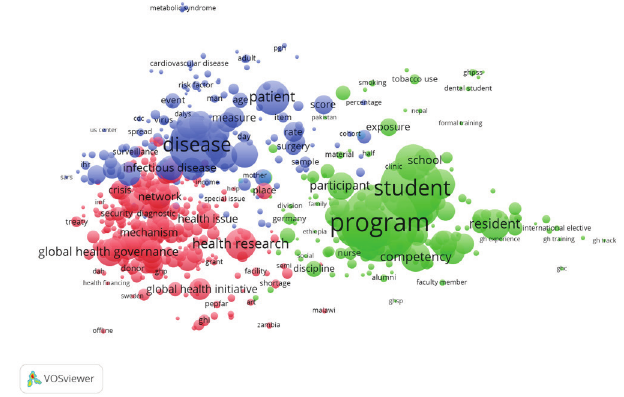
Figure 4. Thematic Map With 3 Color-Coded Clusters of Related Terms. The diameter and label sizes are proportional to the term occurrence in the publications.